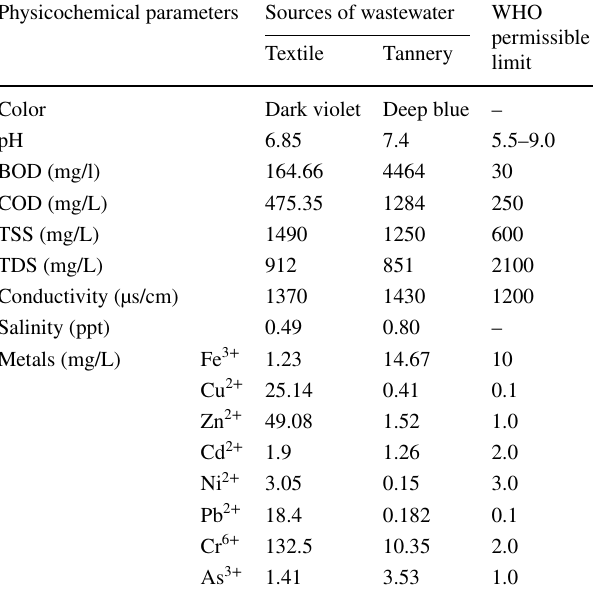
Table 1 Comparison of the physicochemical parameters of textile and tannery EWW with WHO permissible limit Physicochemical parameters Sources of wastewater WHO